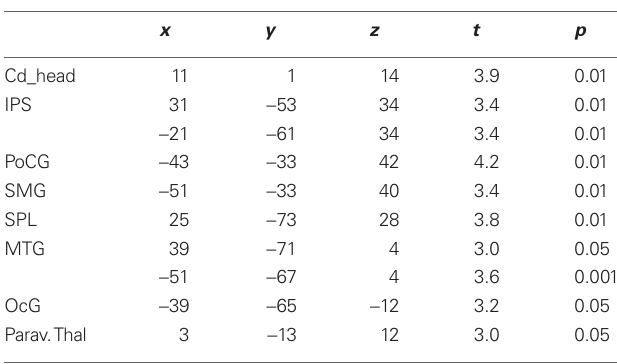
Table 3 | Main effects of sexual arousal.